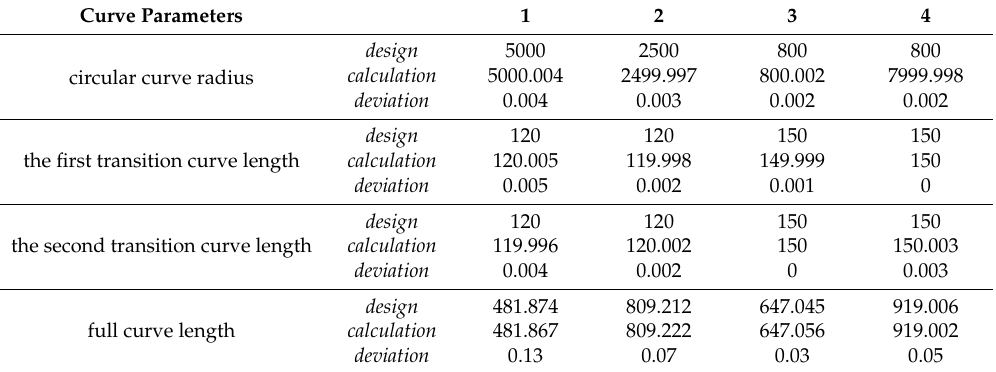
Table 1. The calculation results of curve parameters compared with the design data